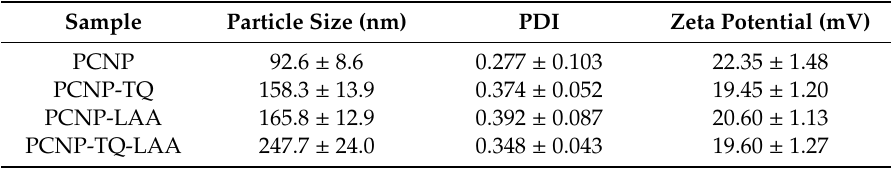
Table 3. Particle size, polydispersity index and zeta potential of all samples; PCNP, PCNP-TQ, PCNP-LAA and